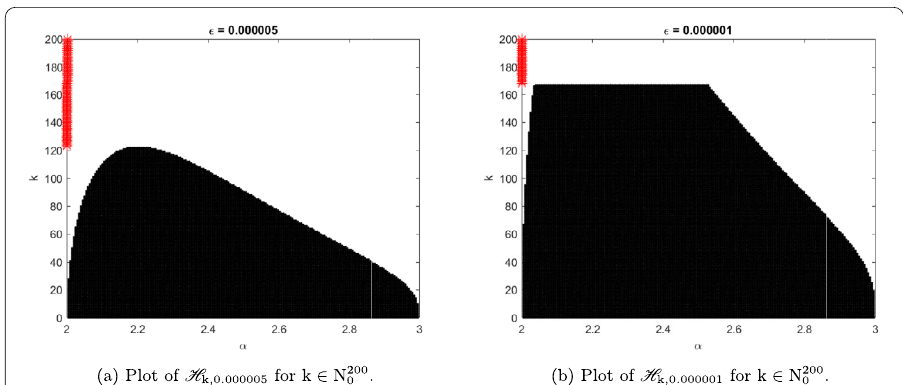
Figure 2 Plot of H k , (cid:4) for k ∈ N 200 0 and different values of (cid:4)